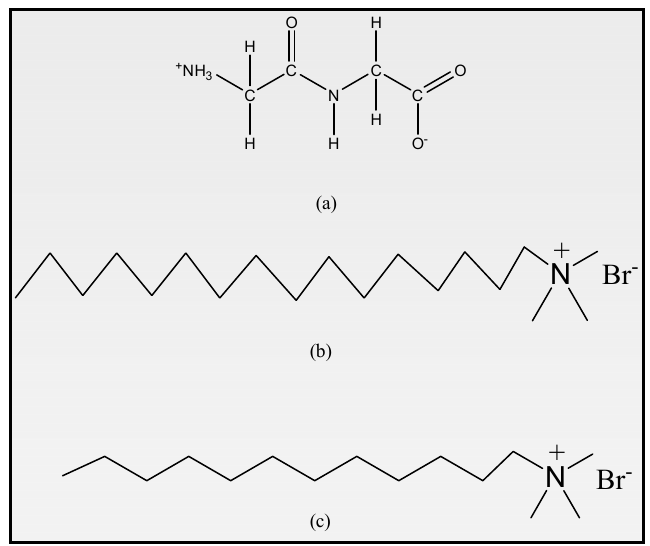
Figure 1. Schematic representation for chemical structure of ( a ) Glycyl dipeptide, ( b ) CTAB and ( c ) DTAB.